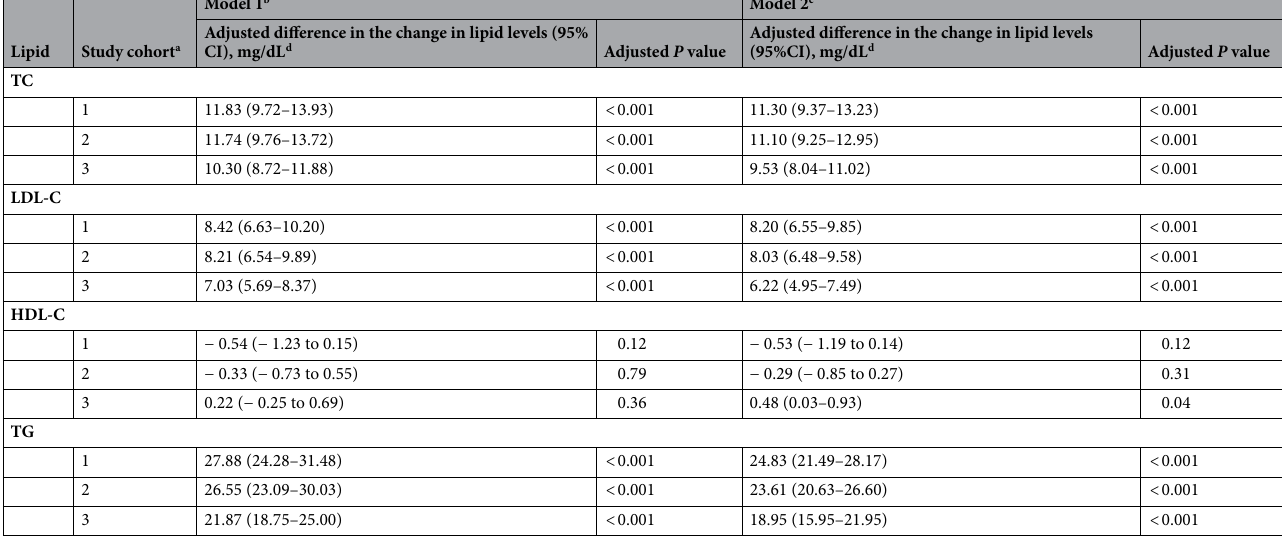
Table 3. Adjusted changes in the lipid levels according to change in vitamin D levels. TC: total cholesterol; LDL-C: low-density lipoprotein cholesterol; HDL-C: high-density lipoprotein cholesterol; TG: triglycerides; CI: confidence interval; SD: standard deviation. a Cohort 1: 2018 versus 2017; cohort 2: 2019 versus 2018; cohort 3: 2020 versus 2019. b Adjusted for age, sex, race, education, body mass index, blood pressure, smoking, geographical location, and vitamin D levels. c Adjusted for age, sex, race, education, body mass index,